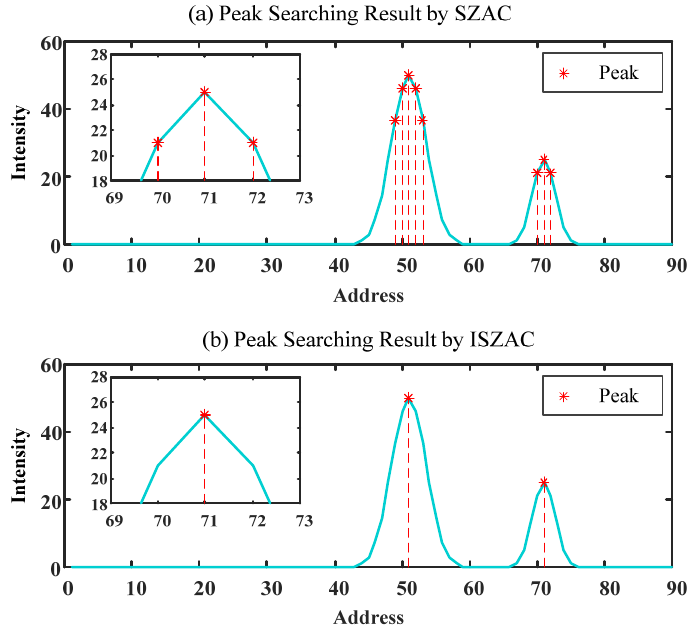
Figure 3. Accuracy verification